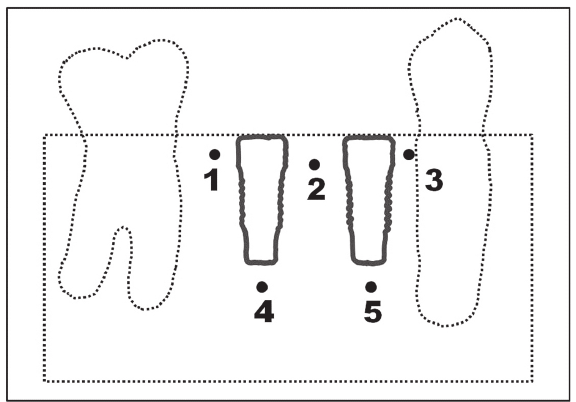
Figure 1- Points of interest selected for the quantitative analysis